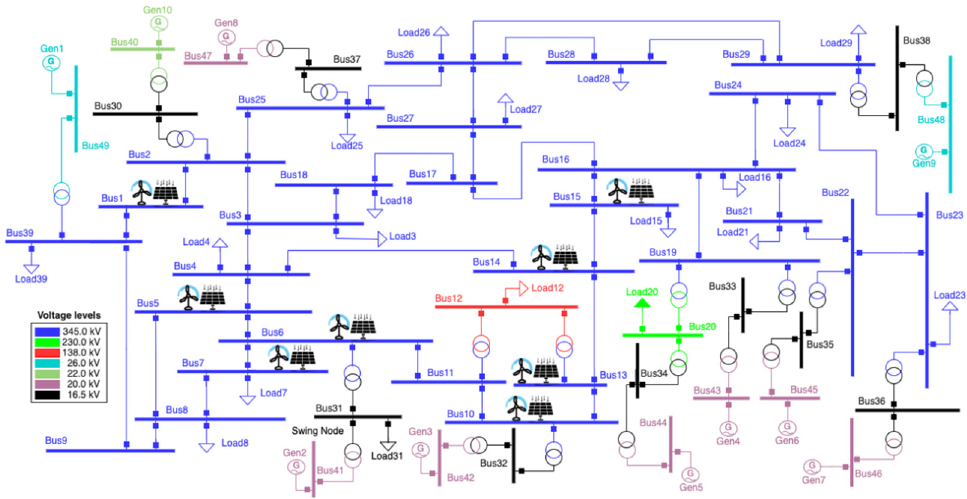
Figure 5. Optimum allocation of PV and wind generation at IEEE New England 39.